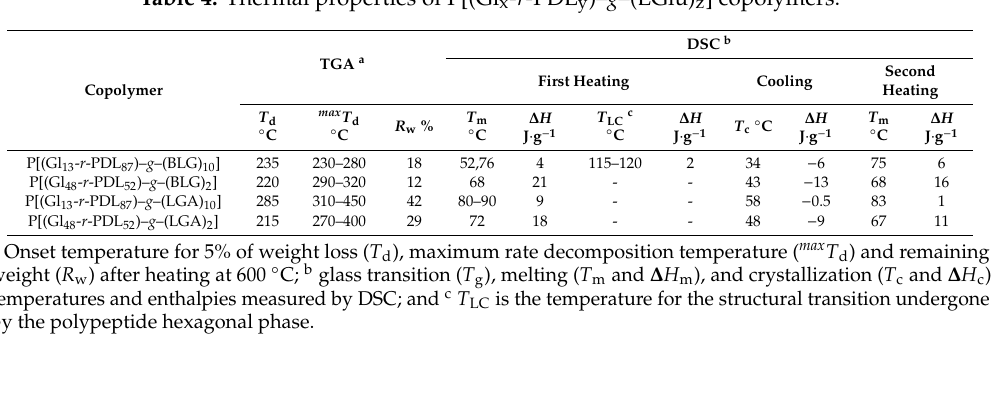
P[(Gl 13 - r -PDL 87 )– g –(BLG) 10 ] a Onset temperature for 5% of weight loss ( T d ), maximum rate decomposition temperature ( weight ( R w ) after heating at 600 ◦ C; b glass transition ( T g ), melting ( T m and ∆ H m ), and crystallization ( T c and ∆ H c ) temperatures and enthalpies measured by DSC; and c T LC is the temperature for the structural transition undergone by the polypeptide hexagonal